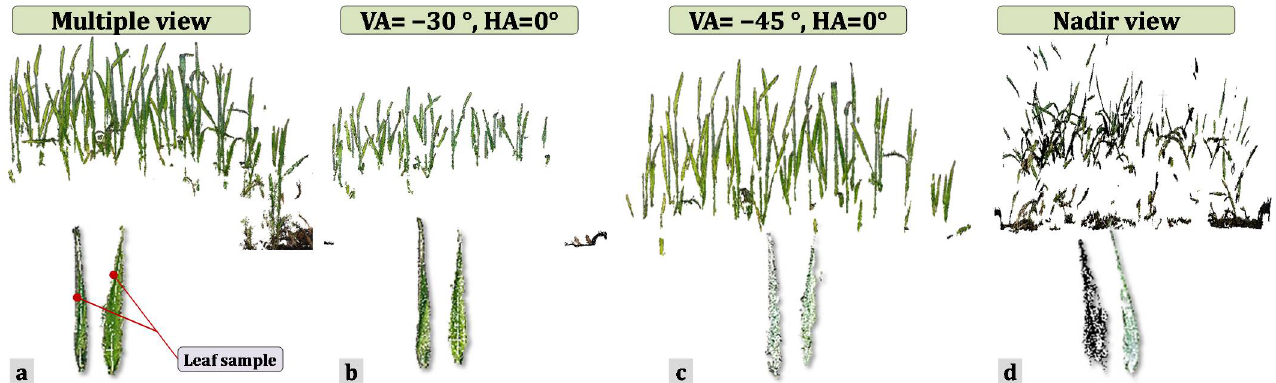
Figure 7. Demonstration of the front view of the BBCH 47, representing camera setting of ( a ) multiple view, ( b ) VA = − 30 ◦ , HA = 0 ◦ , ( c ) VA = − 45 ◦ , HA = 0 ◦ , and ( d ) nadir view. Upper images are generated 3D models. Lower images are two randomly selected leaf samples from multi-view images and single view images.